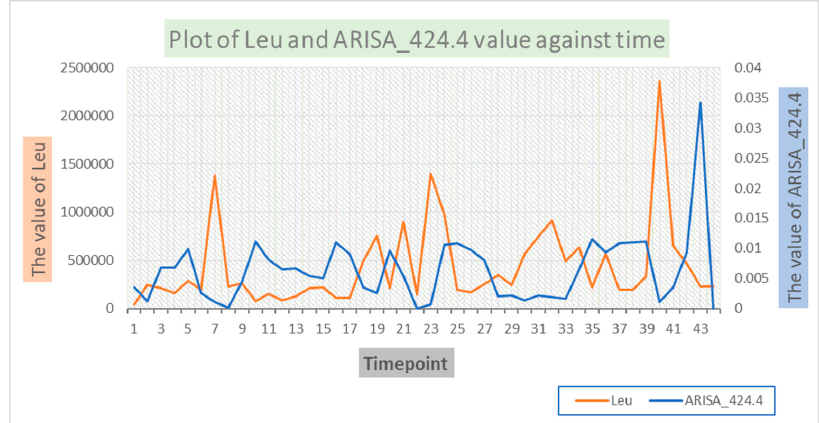
Figure 2. Change of the abundance levels of Leu and ARISA_424.4 over time. It can be seen that the